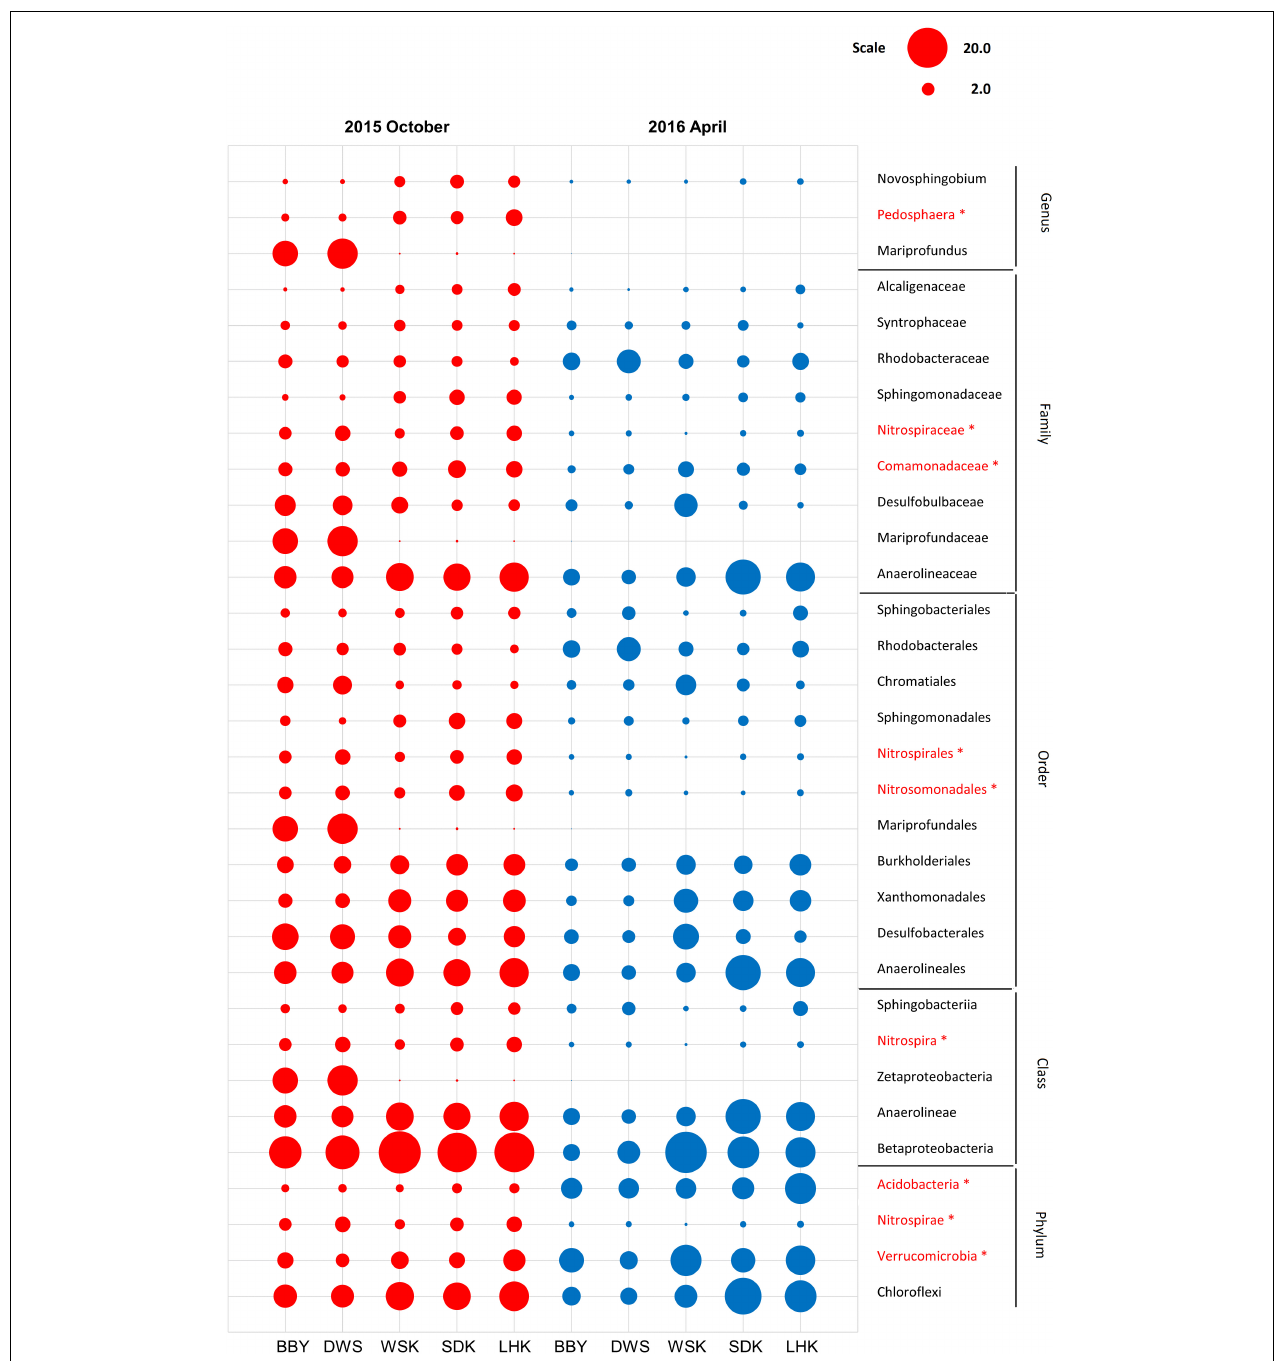
FIGURE 10 | Relative abundances of heavy metal-associated bacterial taxa in sediments from various sites of the Yangtze River estuary (Red = October 2015, Blue = April 2016). Asterisks represent a significant difference between the 2 months according to Welch’s t -test ( P < 0.05).